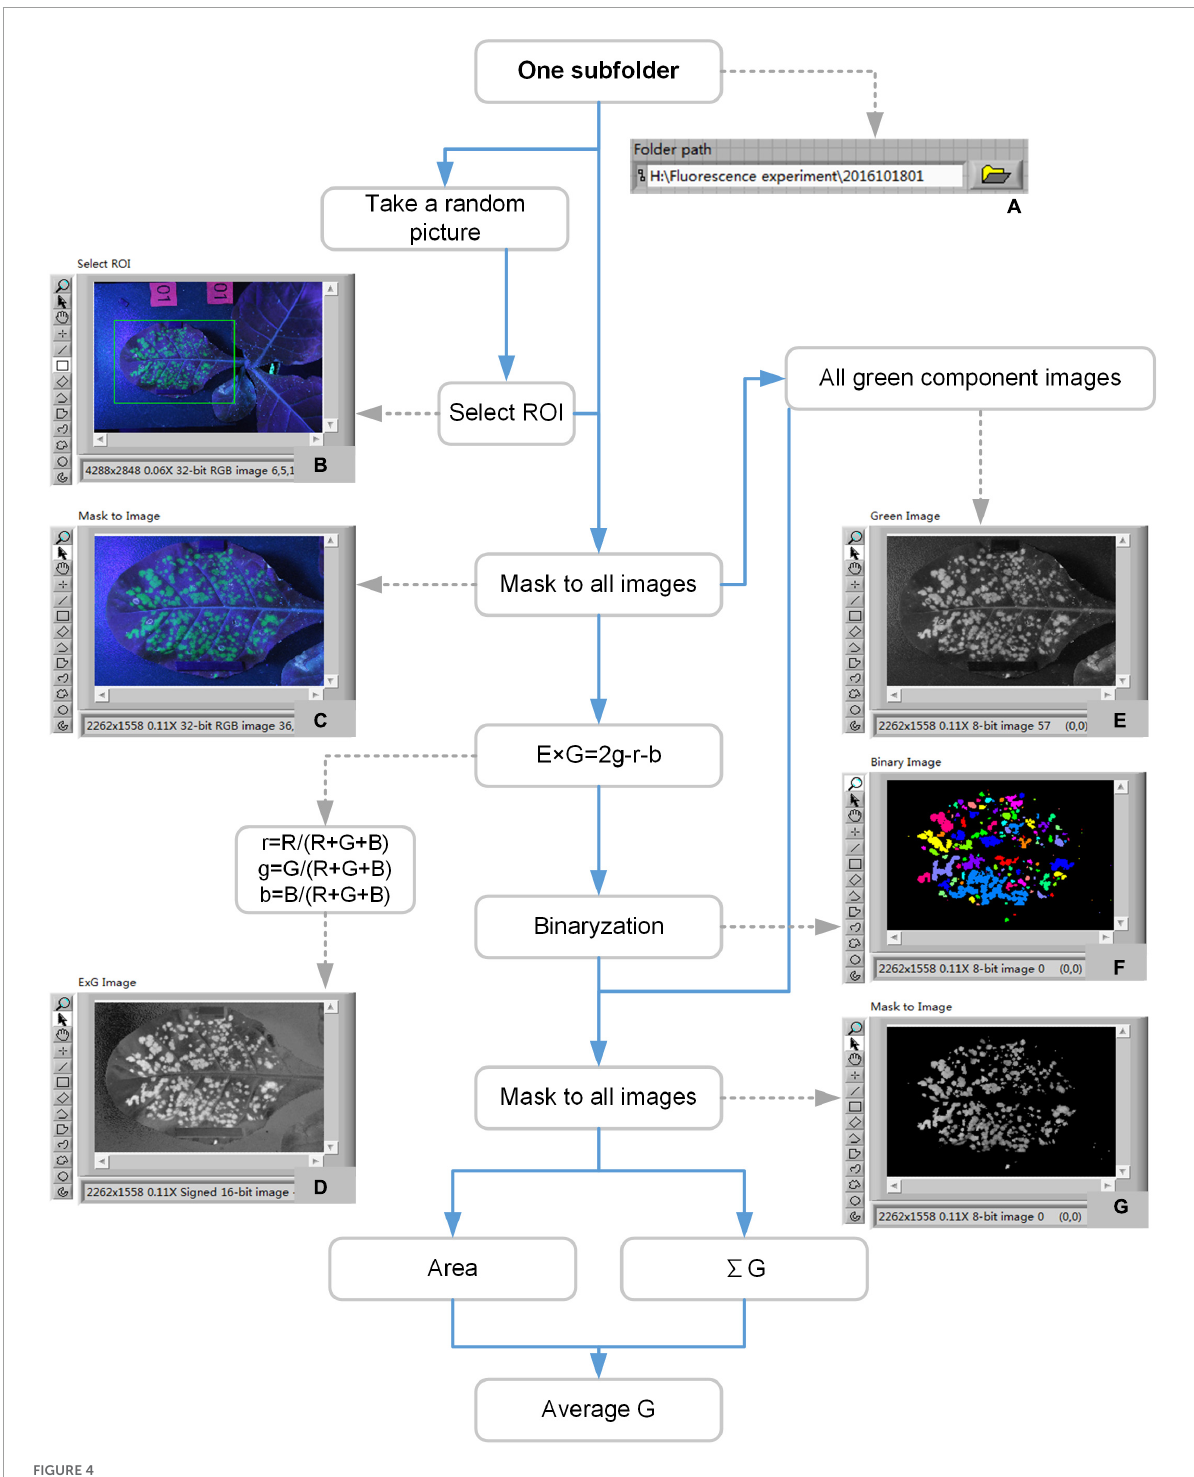
FIGURE4 Flow chart of image processing and data analysis to extract fluorescence-related traits. Panel (A) was the currently processed folder path. Panel (B) was the original image. Panel (C) was the cropped image. Panel (D) was the ExG image. Panel (E) was the green channel image. Panel (F) was the binary pseudo-color image. Panel (G) was the green channel image of the binary